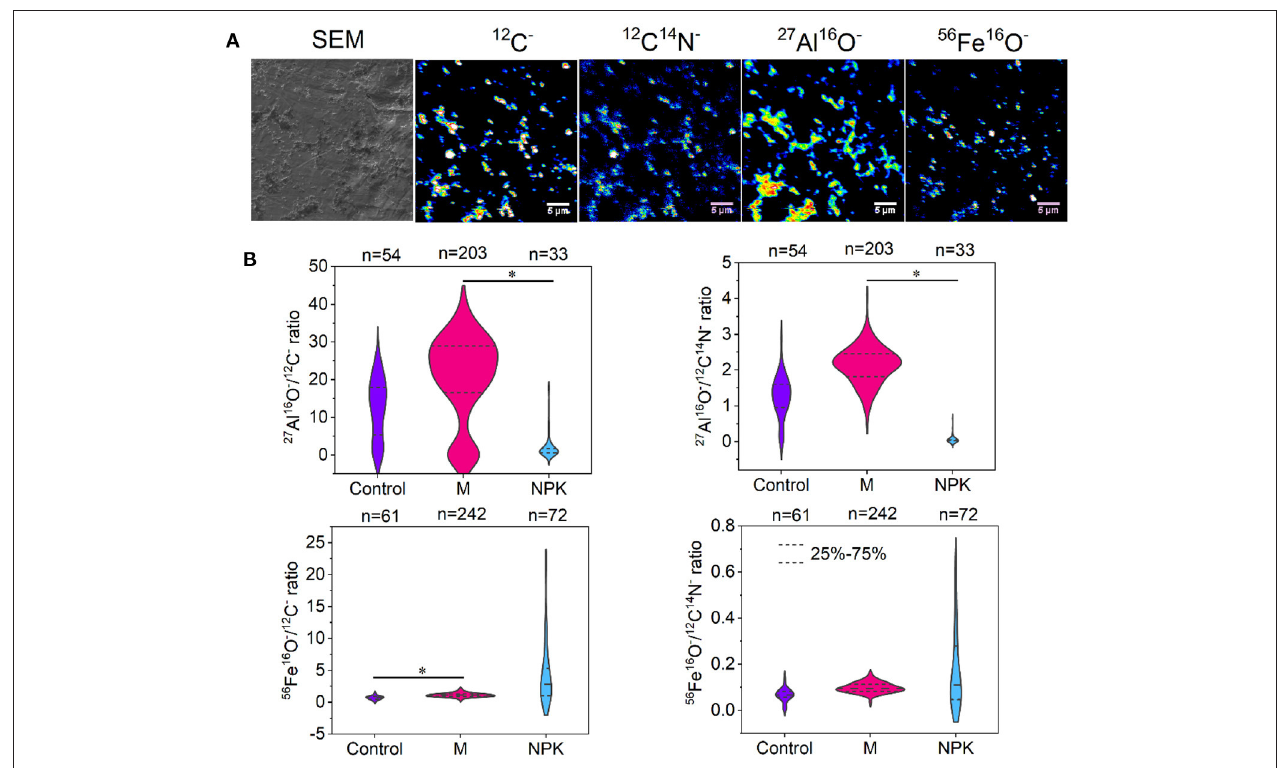
FIGURE 2 | NanoSIMS images (A) and ROI analysis (B) showing associations between minerals and organic matter in soil water dispersible colloids from the different fertilization treatments at the Jiangxi Institute of Red Soils, Jinxian, China. (A) Typical scanning electron microscope (SEM) and nano-scale secondary ion mass spectrometry (NanoSIMS) images. (B) Violin charts of the ratios of minerals and organics based on the region of interest (ROI) analysis. 12 C − , 12 C 14 N − , 27 Al 16 O − , and 56 Fe 16 O − represent organic carbon and organic matter, Al and Fe minerals, respectively. The “n” represents the number of ROIs. * P < 0.05, Student’s t -test. Control, no fertilization; M, farmyard manure fertilization; NPK, chemical